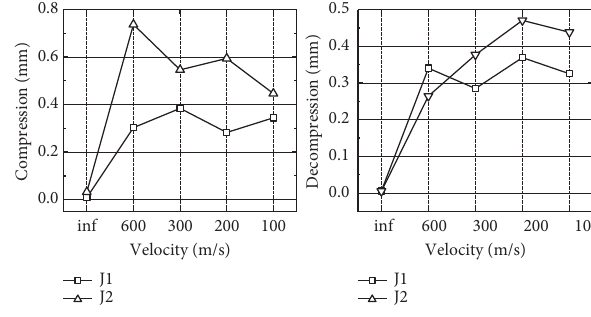
Figure 16: Maximum deformation of joints.